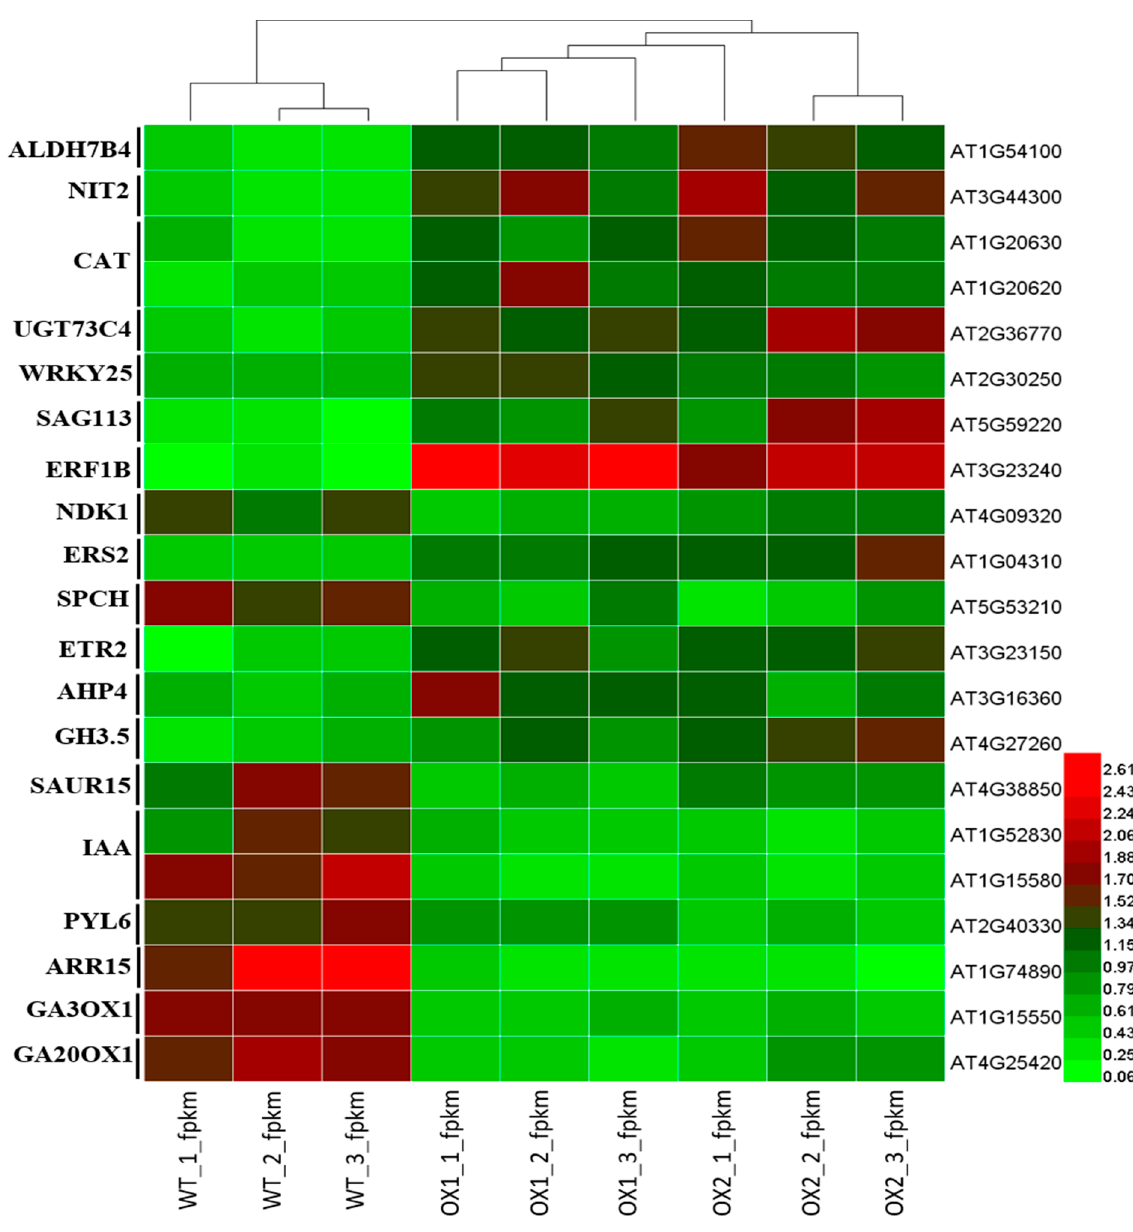
Figure 7. Expression levels of potential DEGs for plant-growth regulation in transgenic plant ( A. thaliana ). The heat map was originated from the log2-fold change (log2FC) and mean value calculated from three replicates of RNA-Seq. data. The color shows the fold change of DEGs under OX1, OX2, and WT, displayed on the right side. The means of RNA-seq. analysis data are the ± SD ( n = 3) and means showing effective difference ( p < 0.05).